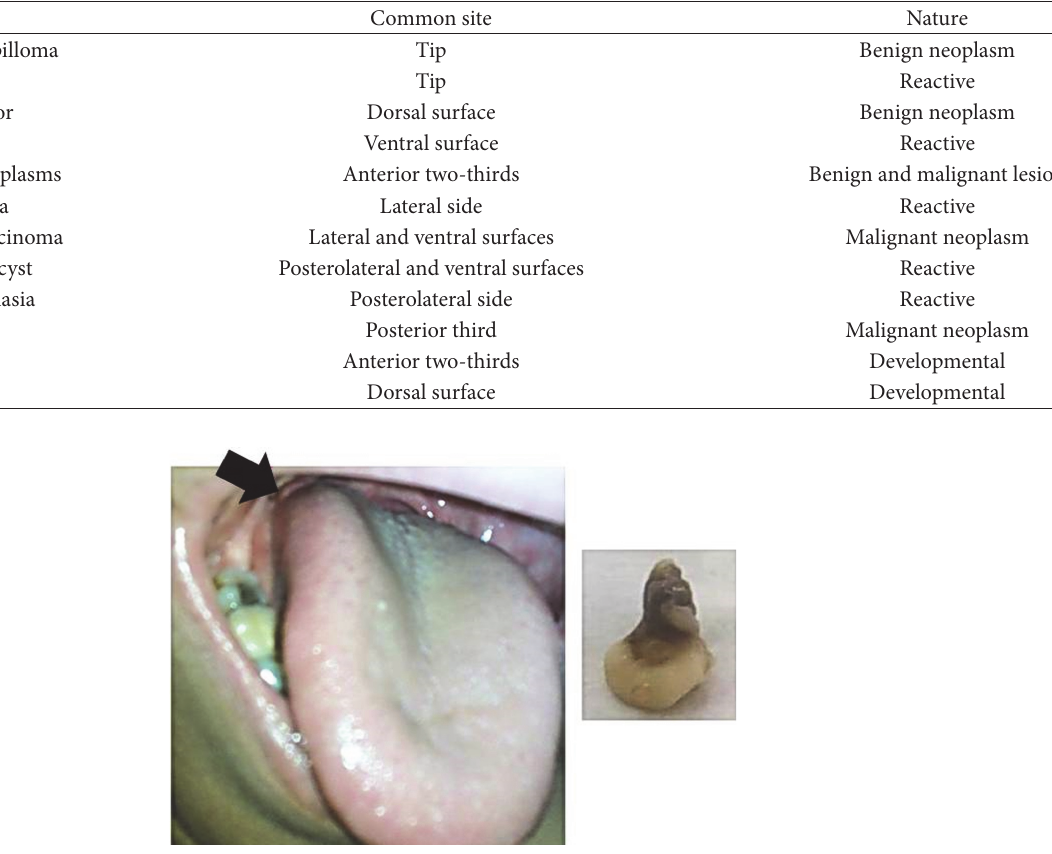
Figure 1: Clinical aspect of lymphoepithelial cyst in relation to the right lateral tongue border and macroscopic picture of the submitted